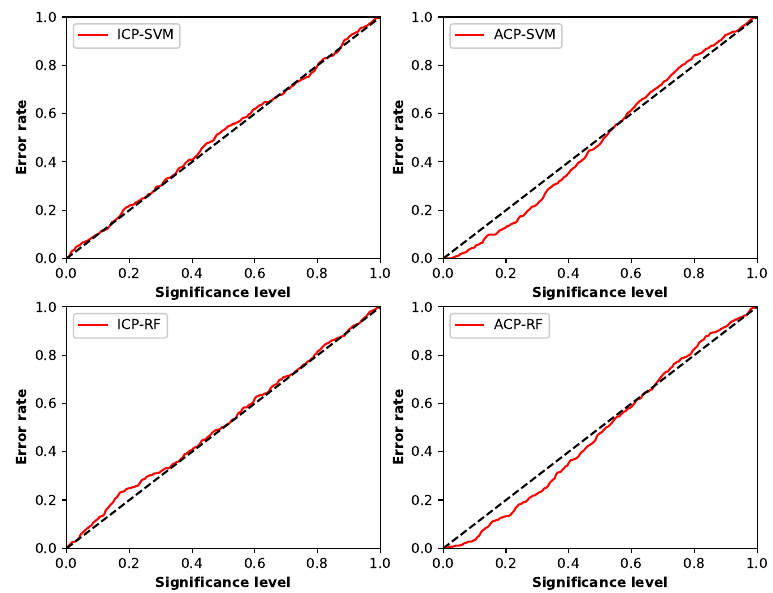
Figure 5. Calibration plot of different conformal